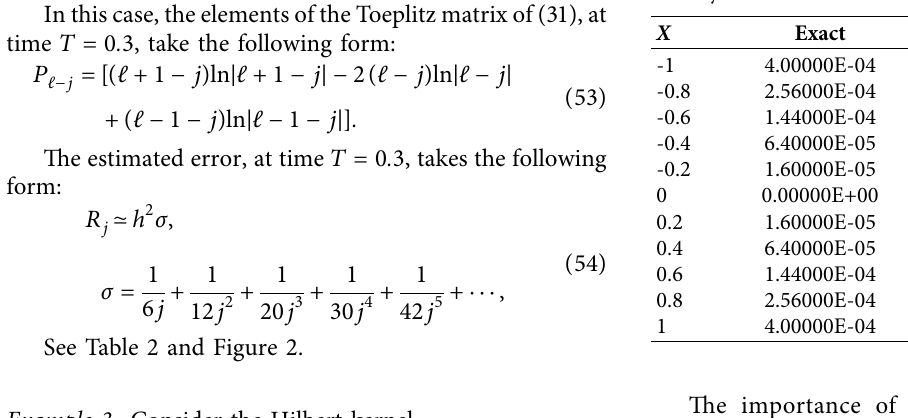
0 . 12 , T 0 . 3 (b) The error of the Caleman kernel (cid:27) (cid:27) Table 2: Describes the numerical solution of equation (1) with the Cauchy kernel and the corresponding